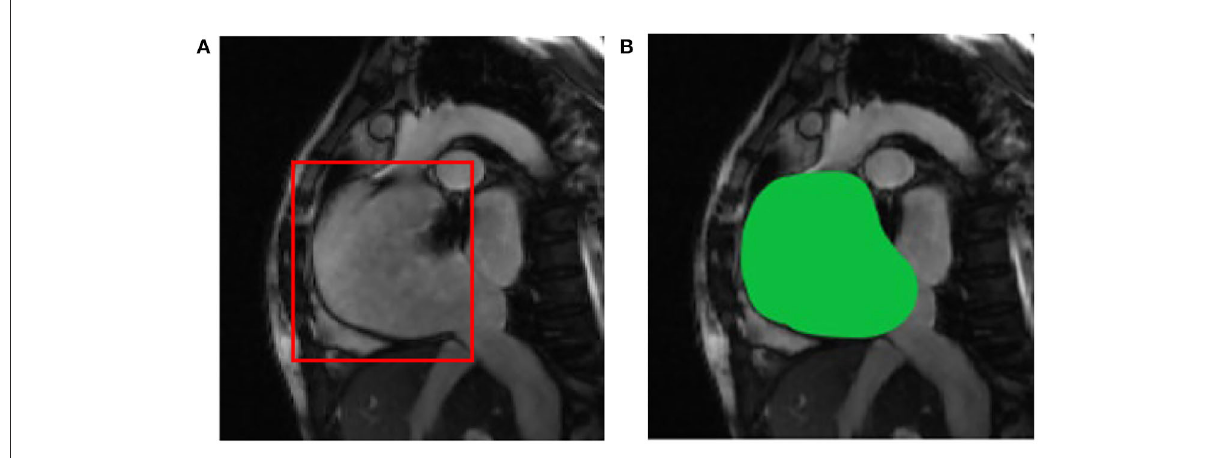
FIGURE4 ROI detection and segmentation results based on (A) the original two-chamber image; and (B) the right atrium image after ROI